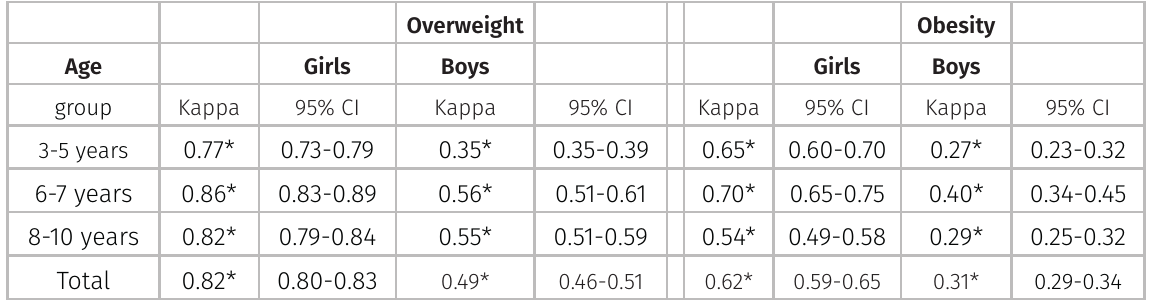
Table II. Agreement Kappa coeffi cient (K) between WHO and IOTF references for overweight and obesity by sex and age group.